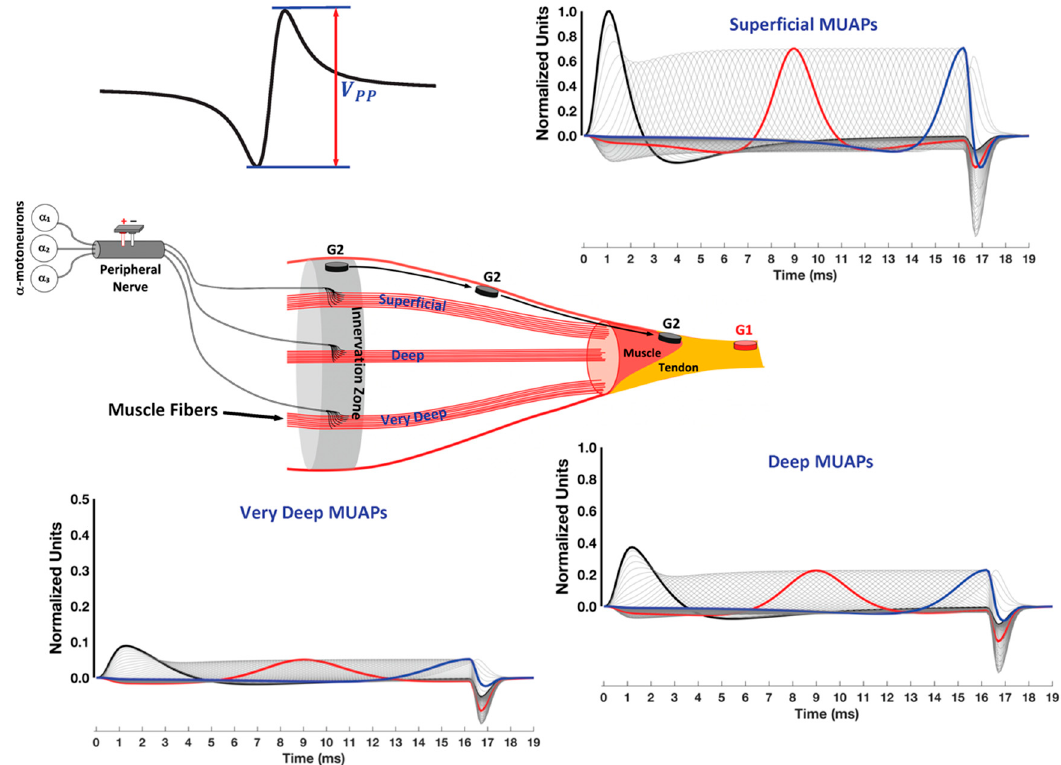
Figure 6. Monopolar recordings of changes in the motor unit action potential (MUAP) shape as the location of G2 is moved longitudinally from the motor point toward the muscle–tendon junction. The black, red, and blue lines correspond to G2 locations at the innervation zone (IZ) mid-point and close to the muscle–tendon junction. The grey lines show the shapes of the MUAPs for incremental G2 locations in between the black, red, and blue lines. Rotating clockwise, starting from the top of the figure, the MUAPs associated with superficial, deep, and very deep muscle fiber locations, respectively, are depicted. The amplitude of the MUAPs in all three graphs is normalized with respect to the peak value of the depolarization phase for the most superficial muscle fibers underneath G2 on the IZ. The G1 electrode is placed on the tendon and serves as the reference electrode for G2. The ground electrode that measures the “offset” potential is not shown.